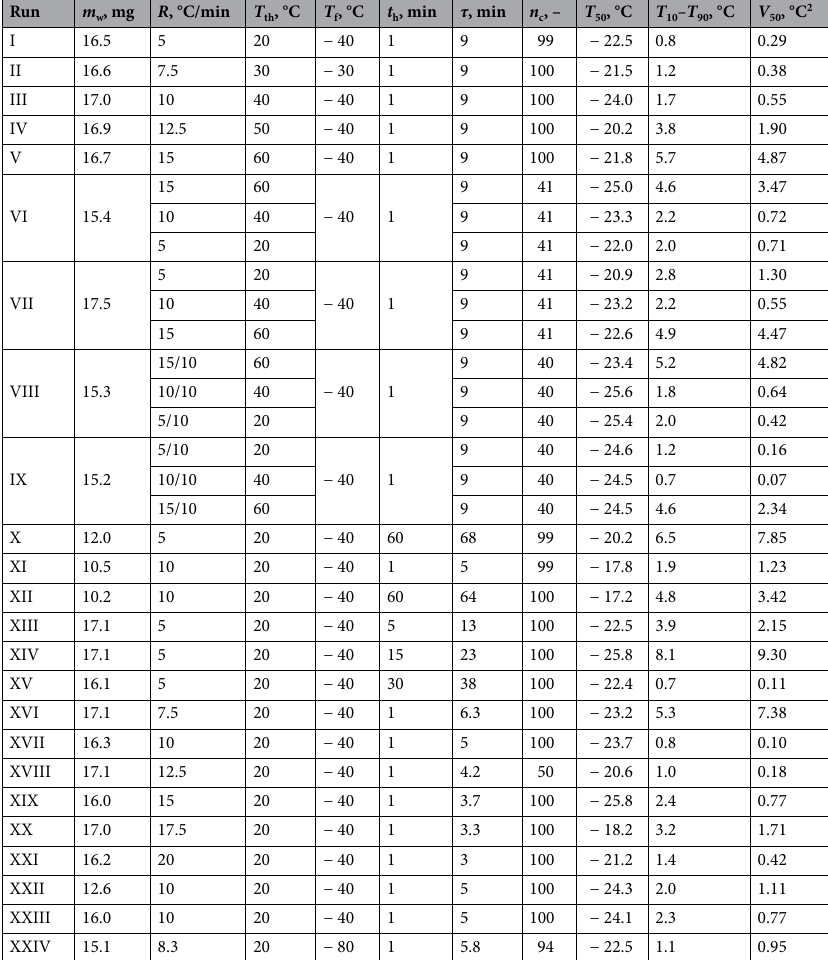
Table 1. Conditions used for the DSC